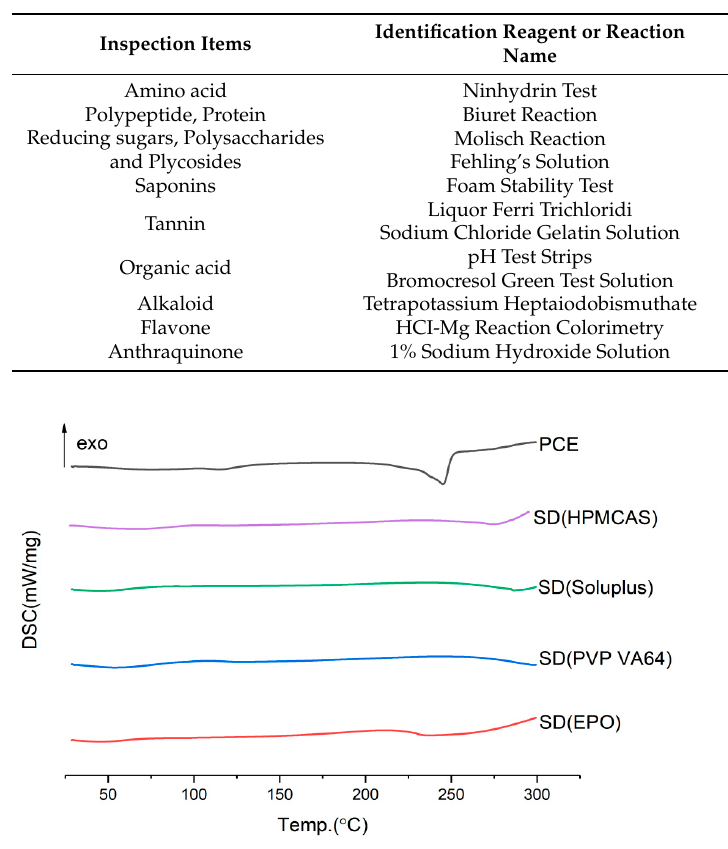
Table 1. The chemical identification results on the composition of accompanying in PCE.